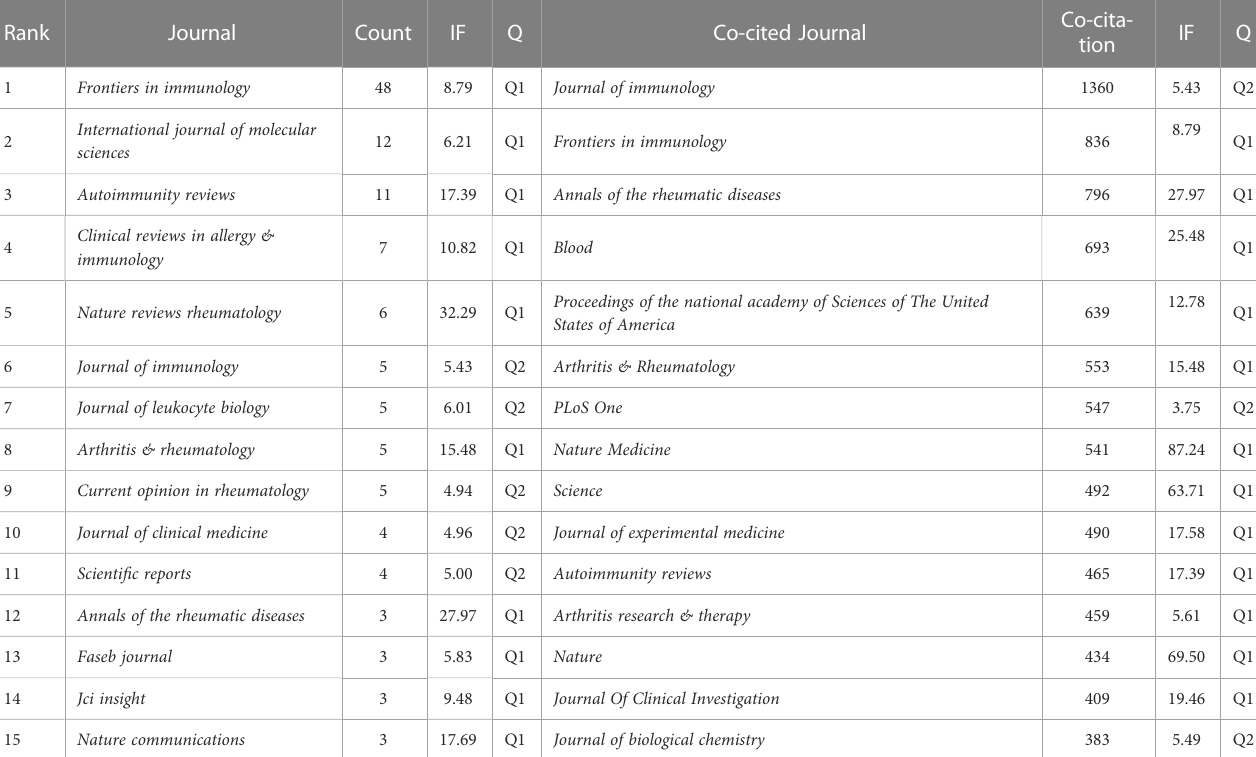
TABLE 2 Top 15 journals and co-cited journals on the research of NETs in